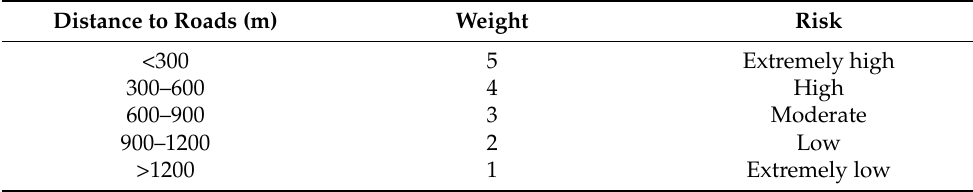
Figure 10. The base map of distance to populated areas in Laoshan. Each level is determined by the fire risk classification. Table 8. Fire risk classification of distance to